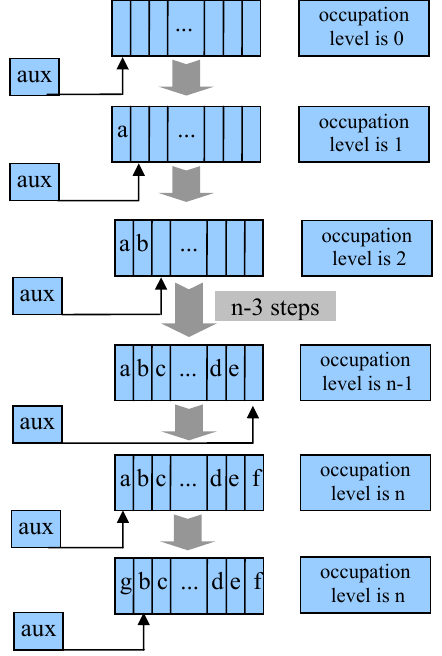
Fig. 4. Circular array